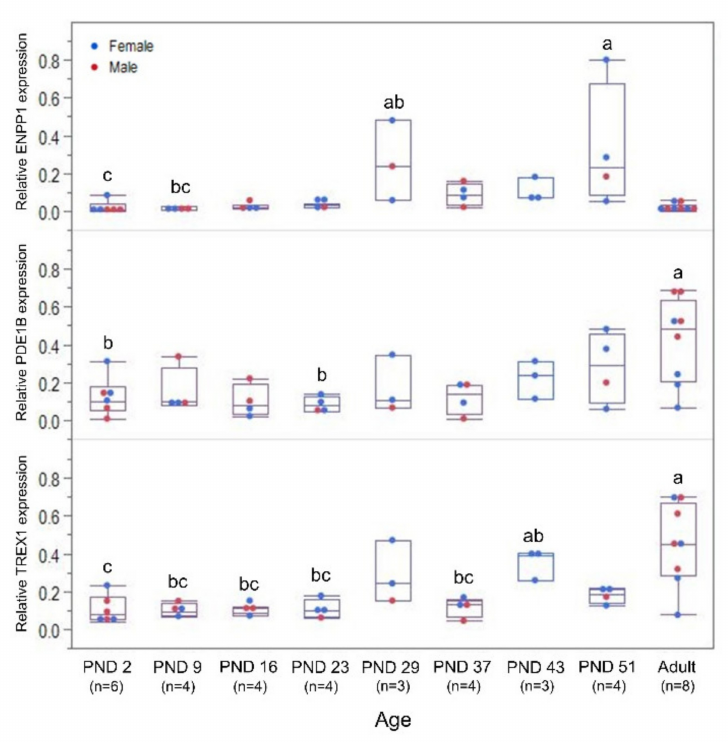
Figure 8. Relative gene expression of 3 (cid:48) -exonucleases: ENPP1 , PDE1B , and TREX1 in the blood over time in the developing and adult Göttingen Minipig. Age groups not sharing the same letter within each gene panel show significantly different gene expression ( p <